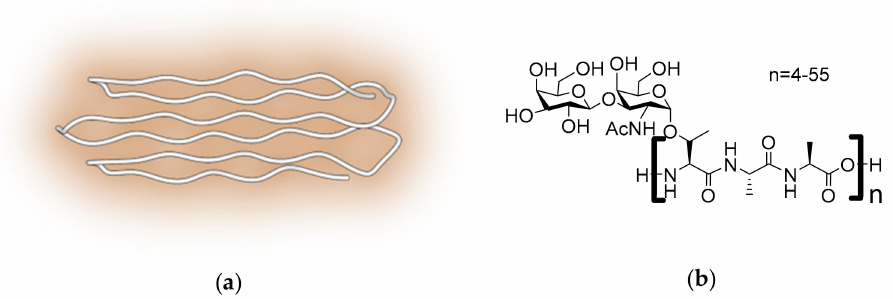
Figure3. PPIIhelixcontainingAFPsandantifreezeglycoproteins. ( a )SnowfleaAFP(PDB:2PNE)showing six short type II polyproline helices; ( b ) Chemical structure of AFGPs from Antarctic